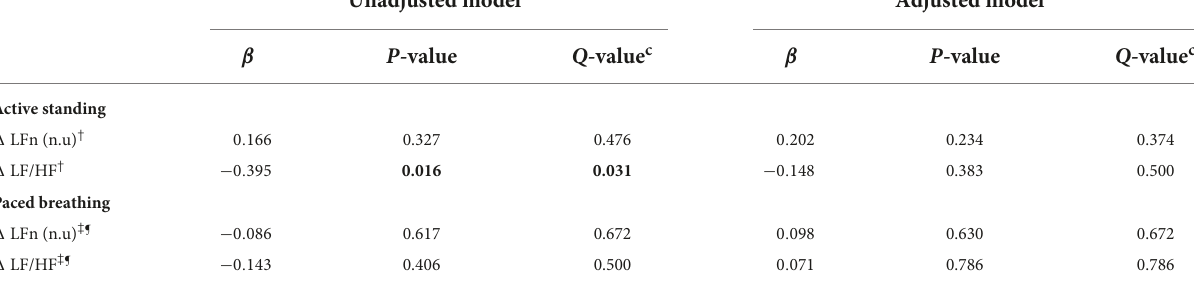
TABLE 3 HRV indices as predictors of cognitive change in subjects with NC at baseline ( n = 37).